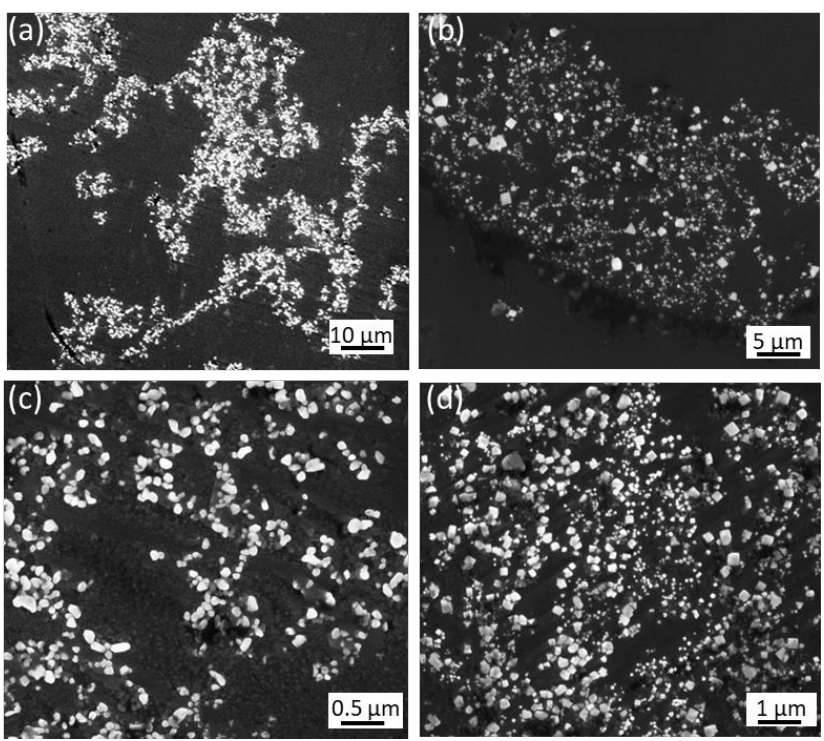
Figure 23. Morphology of MgO films and MgO particles [70]. SEM images showing general morphology of ( a , b ) native MgO films and ( c , d ) native MgO particles dispersed by melt shearing collected from ( a , c ) Mg-9Al and ( b , d ) commercial purity Mg melt. The oxide films are liquid films that contain numerous discrete MgO particles.